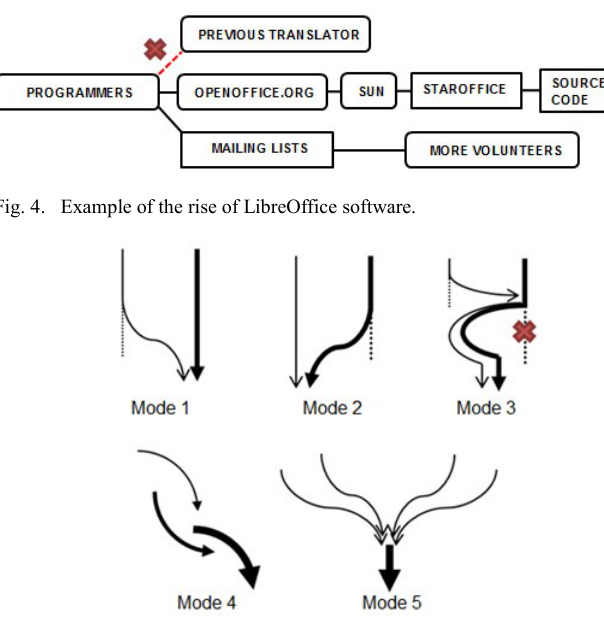
Fig. 5. Modes of translation. Adapted from